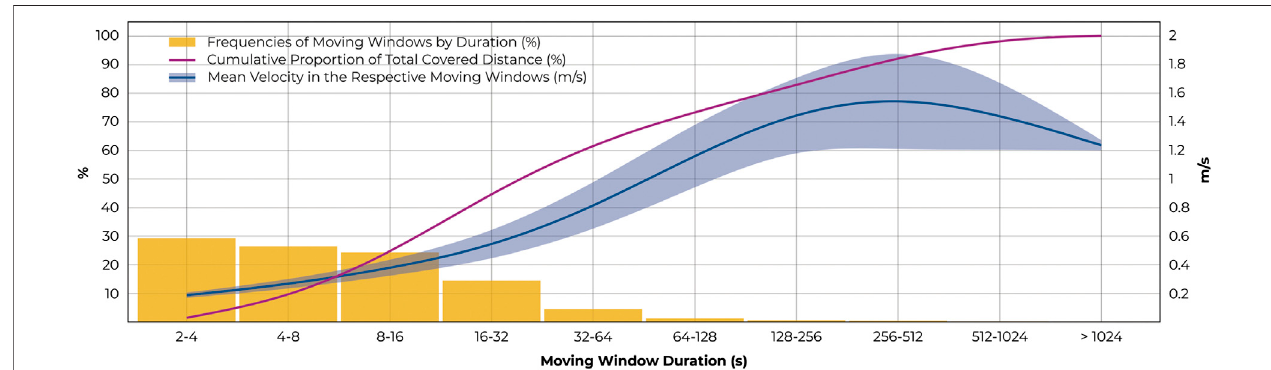
FIGURE3| Relationshipsbetweenduration,distance,andvelocityofmovingwindows.Thedistributionofmovingwindowdurationsisgivenintheyellowbarswhilethe purple line indicates the cumulative proportion of the total covered distance. The mean velocities and standard deviations in the respective data bins are shown in blue.